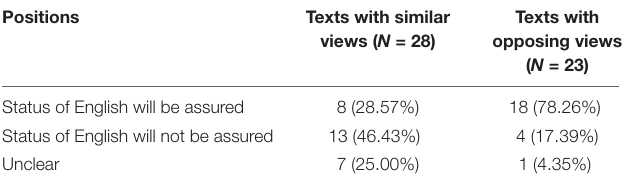
TABLE 4 | Positions supported in essays by two